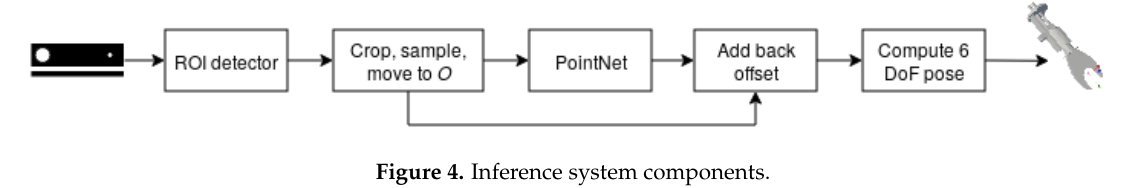
Figure 4. Inference system components.